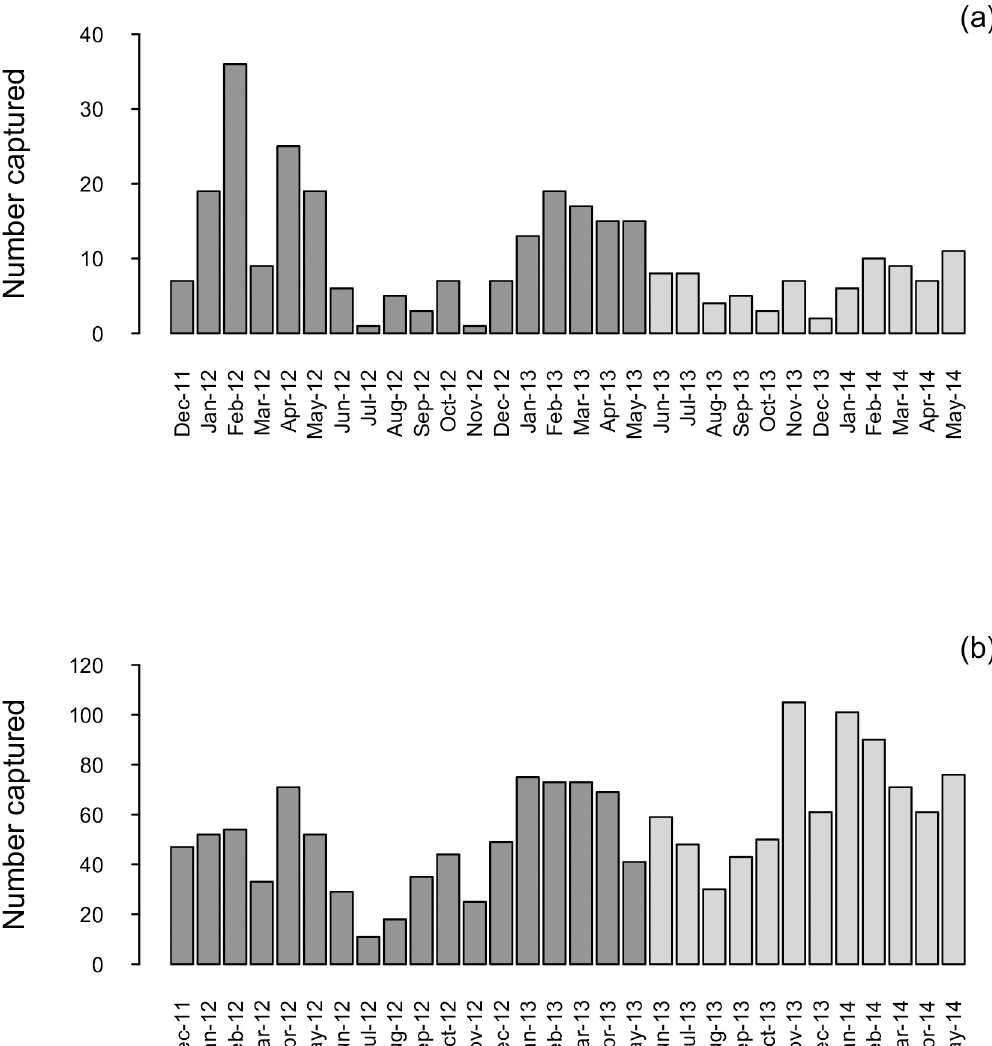
Fig 2. Predator (a) and non-target (b) mammals captured monthly; data used for simulations are highlighted in light grey. Note the differing dependent-axis scales.